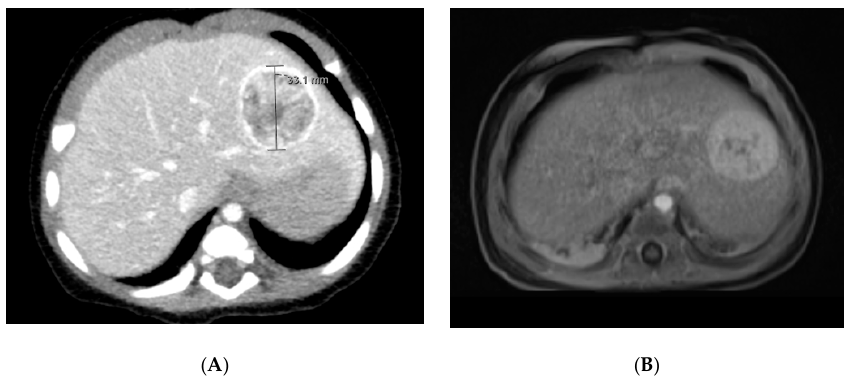
Figure 1. CT and MRI Imaging of Unifocal Hemangioma. ( A ) CT: The liver is remarkable for a well-circumscribed rounded lesion in the left lobe of the liver. This measures approximately 3.3 cm in anterior–posterior dimension by 3.1 cm in transverse dimension by 2.4 cm in craniocaudal dimension. There is intense peripheral enhancement with mixed enhancement of the internal portion of this lesion. ( B ) MRI: A large T2 hyperintense well circumscribed mass is seen in left lobe within segment 2 and 3 of the liver measuring 2.9 × 2.9 × 2.5 cm in anterior-posterior, transverse and craniocaudal dimensions. It demonstrates peripheral nodular enhancement with centripetal contrast filling.